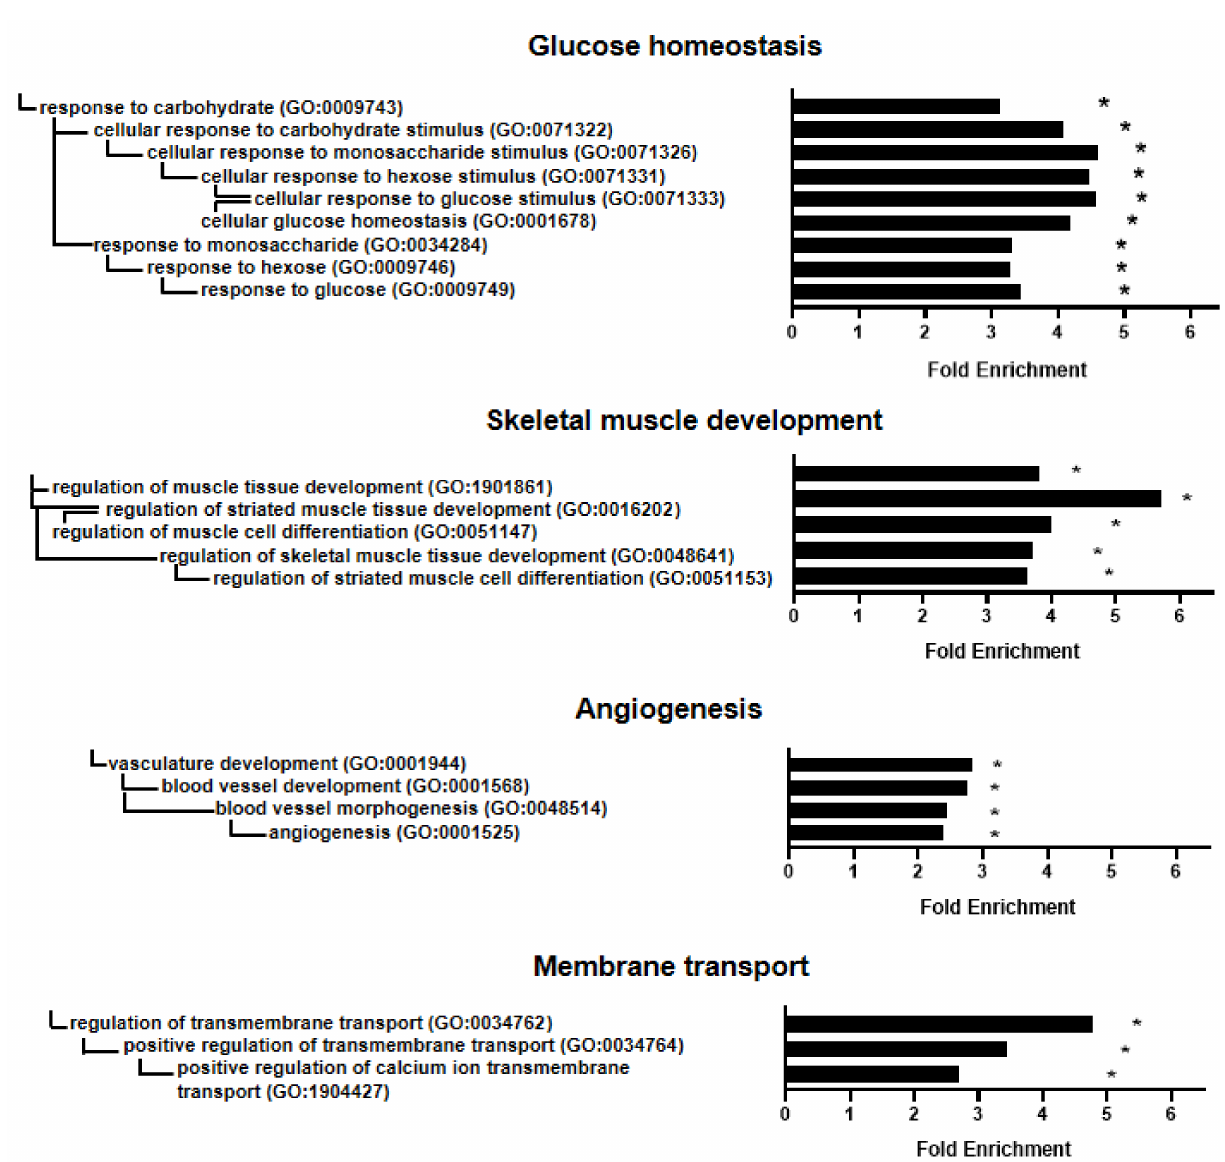
Figure 5. Gene ontology enrichment analysis (biological processes) of all microRNA target mRNAs ( n = 882) highlights the effect of the ProtectomiR microRNAs on glucose homeostasis, skeletal muscle development, angiogenesis and membrane transport. A total of 21 biological processes out of the 25 with the highest fold enrichment value are presented here. * p < 0.05, vs. control (gene ontology enrichment analysis with Bonferroni